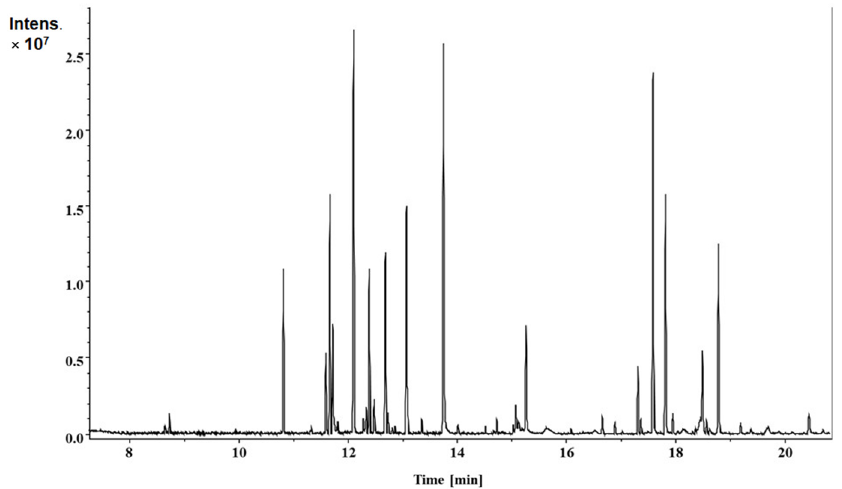
Figure 1. The chromatogram was obtained during GC-MS analysis of CAE. The tentative identifica- tion of the detected peaks corresponds to the data included in Table 1.